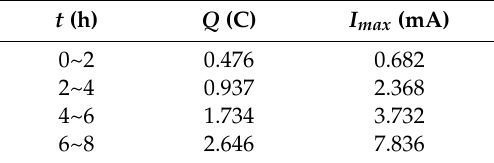
Table 4. Specific values of leakage currents at di ff erent time periods (DC 3.2 kV, γ 20 = 5000 µ S /